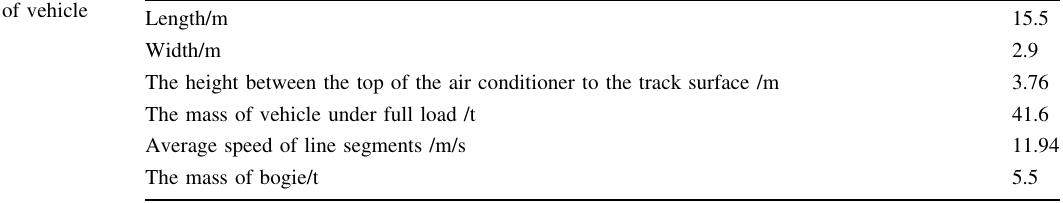
Table 3 Parameter of vehicle